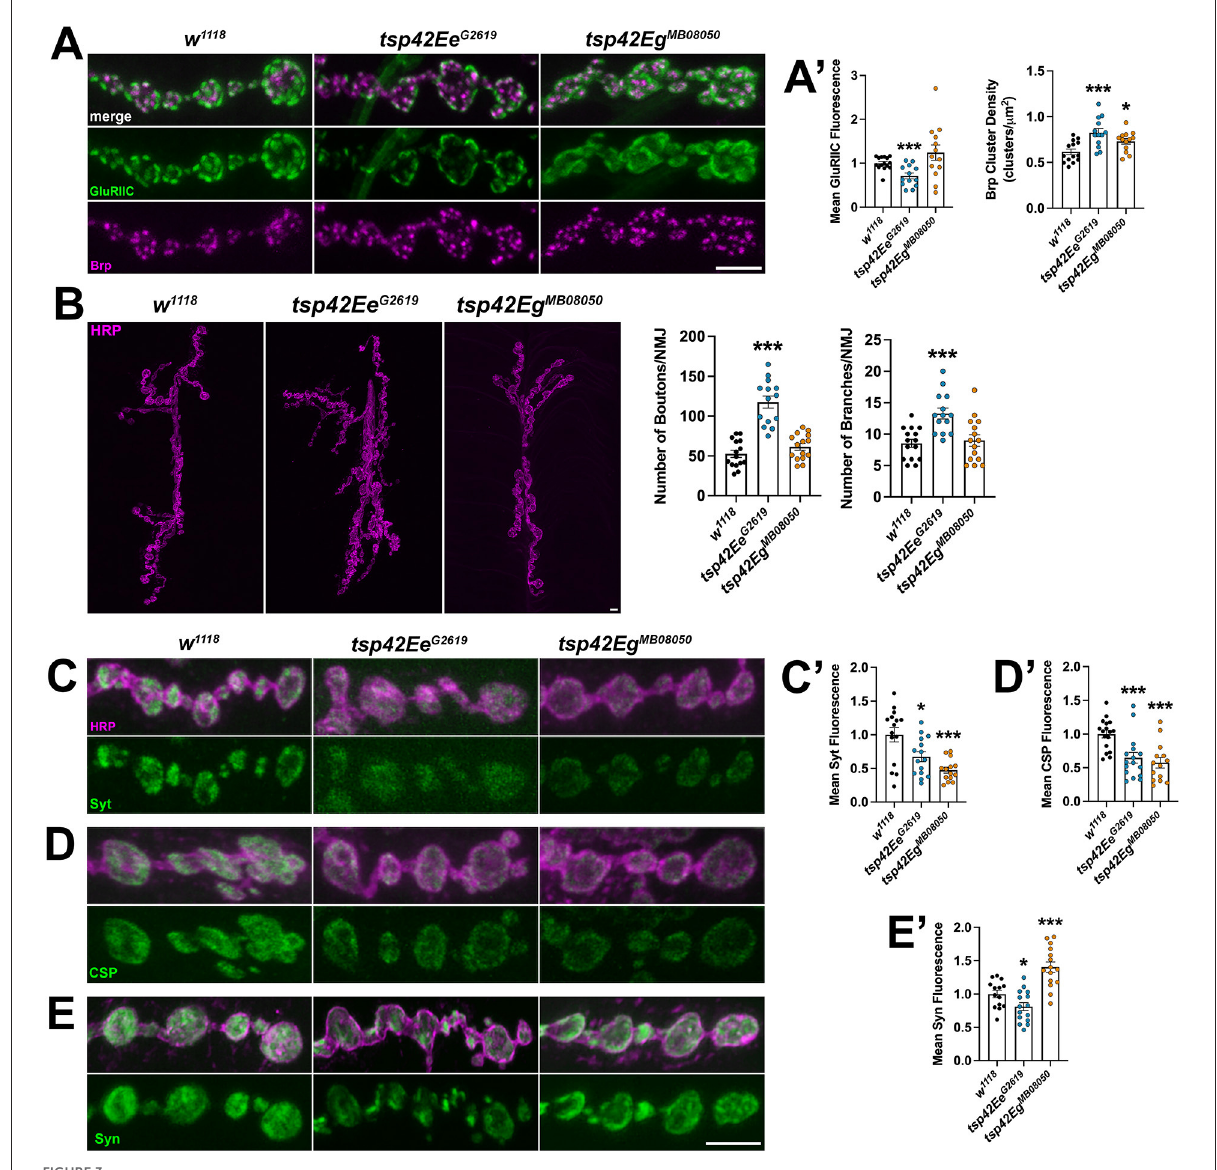
FIGURE3 Tsp42Ee and Tsp42Eg are important for active zone organization and vesicle-associated protein localization. (A) Panels show representative images of control ( w 1118 ) and tsp mutant boutons immunolabeled for the active zone marker, Brp (magenta), and postsynaptic glutamate receptor subunit, GluRIIC (green). (A’) Quantification of mean Brp puncta density and fluorescence intensity of GluRIIC. Brp density is significantly increased in both tsp42Ee G 2619 ( p = 0.0006) and tsp42Eg MB 08050 ( p = 0.0142) mutants. GluRIIC fluorescence is significantly reduced in tsp42Ee G 2619 mutants ( p = 0.0005). (B) Confocal images of HRP-labeled 6/7 NMJ’s (left) and quantification of bouton and branch number (right). Boutons ( p < 0.0001) and branch numbers ( p = 0.0001) were significantly increased in tsp42Ee G 2619 mutants. (C–E) Representative confocal images showing HRP-labeled neurons (magenta) and the localization of Syt (C) , CSP (D) , or Syn (E) (green). Right bar graphs show quantification of immunofluorescence normalized to w 1118 controls. Mean Syt fluorescence (C’) is significantly reduced in tsp42Ee G 2619 ( p = 0.0168) and tsp42Eg MB 08050 ( p = 0.0001) mutants. Mean CSP fluorescence (D’) is significantly reduced in tsp42Ee G 2619 ( p = 0.0010) and tsp42Eg MB 08050 ( p < 0.0001) mutants. Mean Syn fluorescence (E’) is significantly reduced in tsp42Ee G 2619 mutants ( p = 0.0295) but increased in tsp42Eg MB 08050 mutants ( p = 0.0003). Scale bars = 5 µ M. Errors bars represent SEM. Unpaired t tests were used for all statistical comparisons.